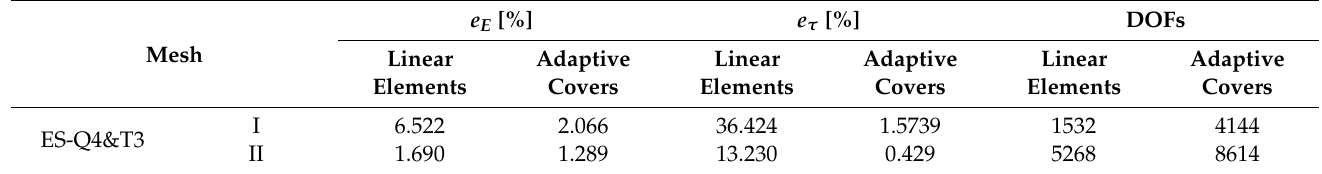
Numerical results obtained employing the edge-based smoothed finite elements (ES- FE) are compared with the results of the adaptive enrichment scheme. Table 4 gives the relative errors in the energy norm in Equation (27) and maximum von Mises stress that are averaged stress values at each node in Equation (26). The von Mises stress distributions are given in Figure 12 and the reference solutions are obtained employing a mesh of 9058 nine-node quadrilateral elements. Table 4. Relative errors (%) in the energy norm ( E ) and the maximum von Mises stress ( τ ) at point A in the wheel problem. e E [%] e τ [%] DOFs Mesh